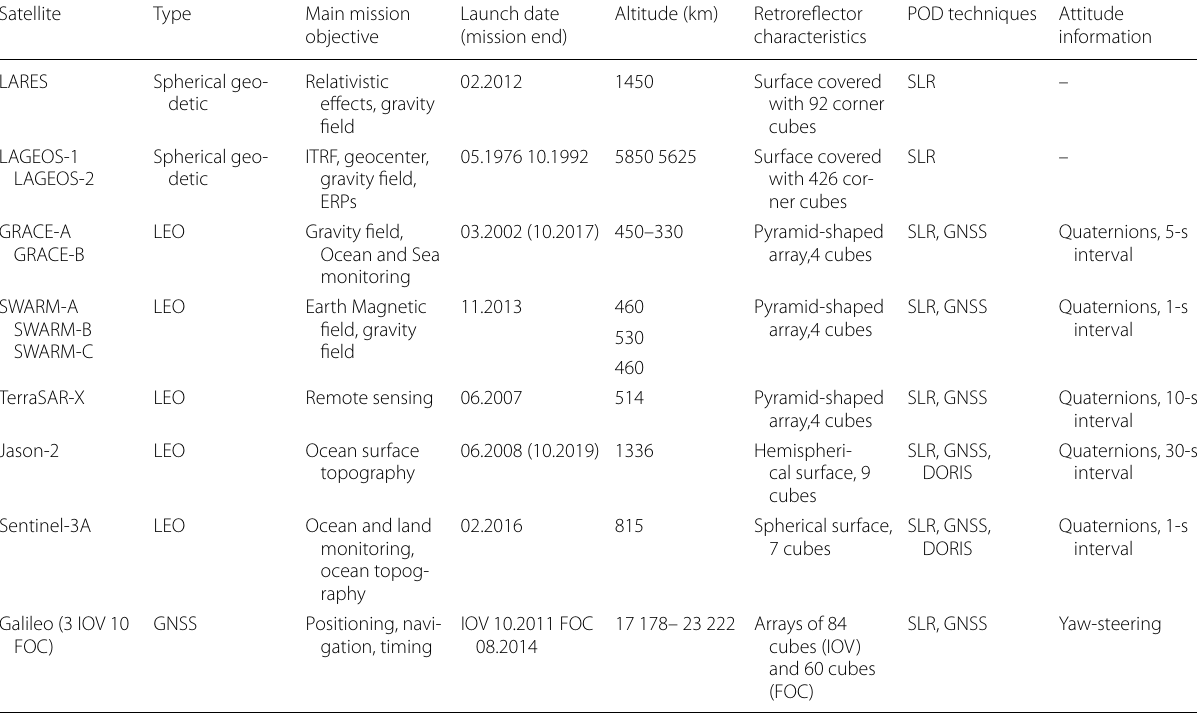
Table 1 Characteristics of different types of satellites with SLR retroreflectors used in the analysis